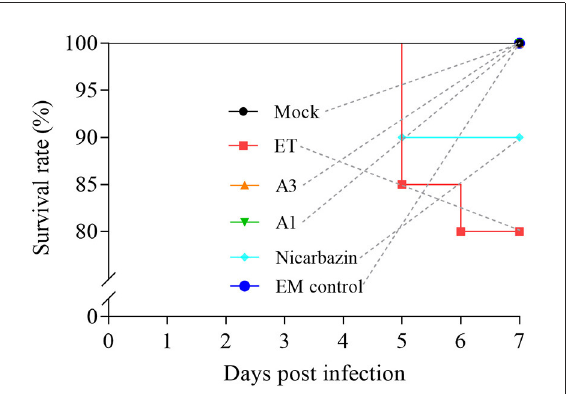
FIGURE4 Evaluation of the FCR of chickens in vivo from Day 1–7 p.i. A3 and A1 represent the EM treatment 3 days before and 1 day after ET infection, respectively. EM, extract and essential oil mixture (non-toxic concentrations of Punica granatum L., Plantago asiatica L., Bidens pilosa L., Acalypha australis L., Pteris multifida Poir, and Portulaca oleracea L. sp. Pl. extracts and Artemisia argyi Levl. et Vant. and Camellia sinensis [L.] O. Ktze essential oils); ET, Eimeria tenella ; FCR, feed conversion ratio. Lowercase letters (a-d) indicate statistically significant differences ( P < 0.05).